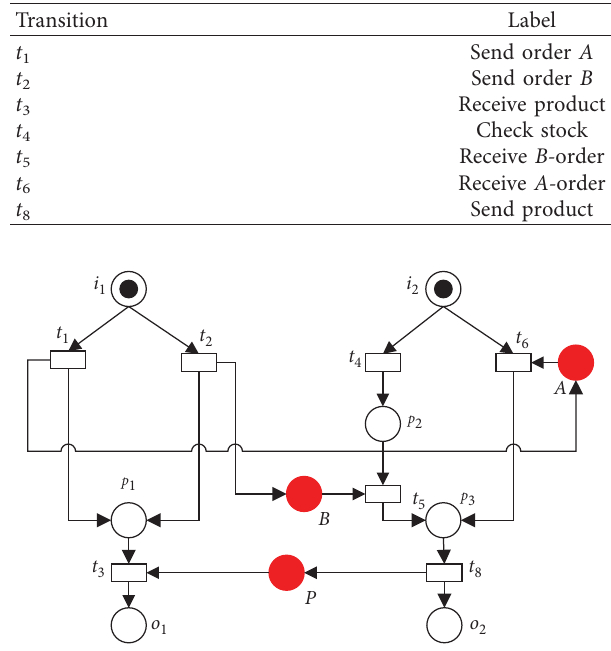
Figure 4: Collaborative business process